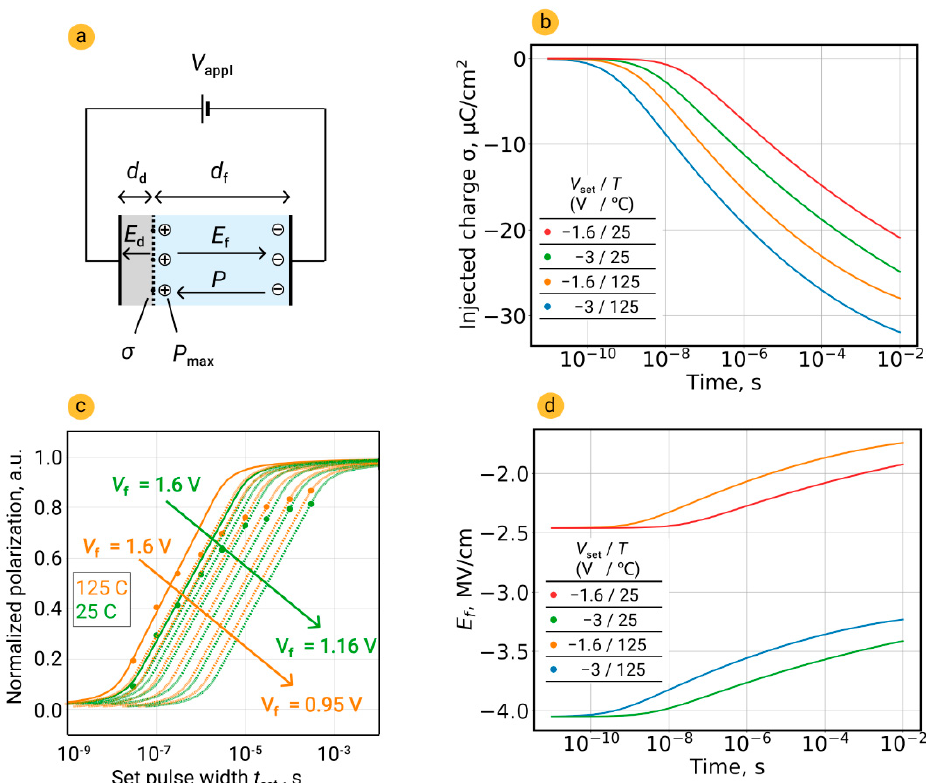
Figure 3. Impact of charge injection on retardation behavior of polarization switching kinetics. ( a ) Sketch of the electroded structure consisting of the interfacial dielectric and ferroelectric layers. ( b , d ) Temporal dynamics of injected charge and real profile of electric field across ferroelectric during passing the set pulse. ( c ) Examination of the impact of the charge injection during the set pulse on the retardation of polarization switching. Dots are experimental points; solid lines are simulation curves from Equations (7)–(10).